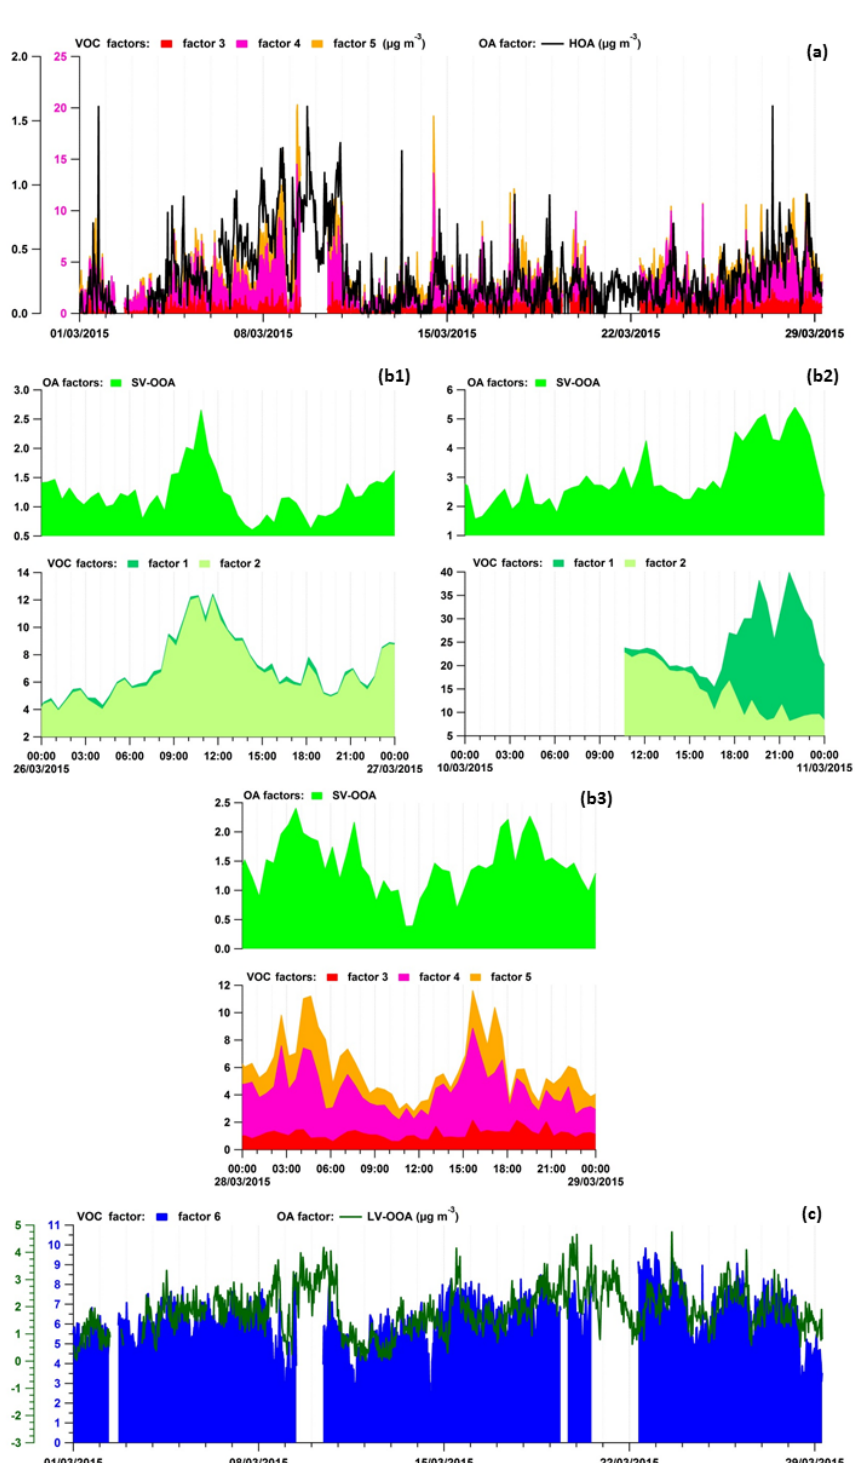
Figure 17. Time series of OA and VOC factor contributions in March 2015 (a, c) or on selected days of the intensive field campaign (b1–b3) to point out covariations and confirm average daily variations presented in Fig. S10. VOC factors: factor 1 – biogenic source 1; factor 2 – biogenic source 2; factor 3 – short-lived combustion source; factor 4 – evaporative sources; factor 5 – industrial and evaporative sources; factor 6 – regional background. OA factors: HOA – hydrogen-like OA; SV-OOA – semi-volatile oxygen-like OA; LV-OOA – low-volatility oxygen-like